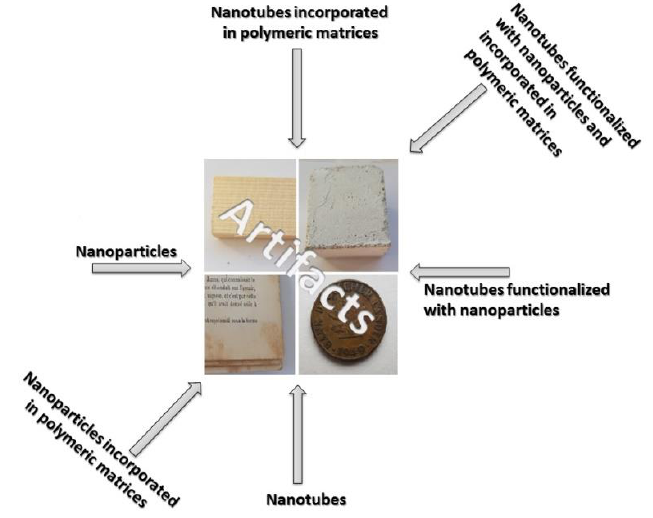
Figure 2. Nanomaterials used as consolidates in conservation and restoration of cultural heritage.